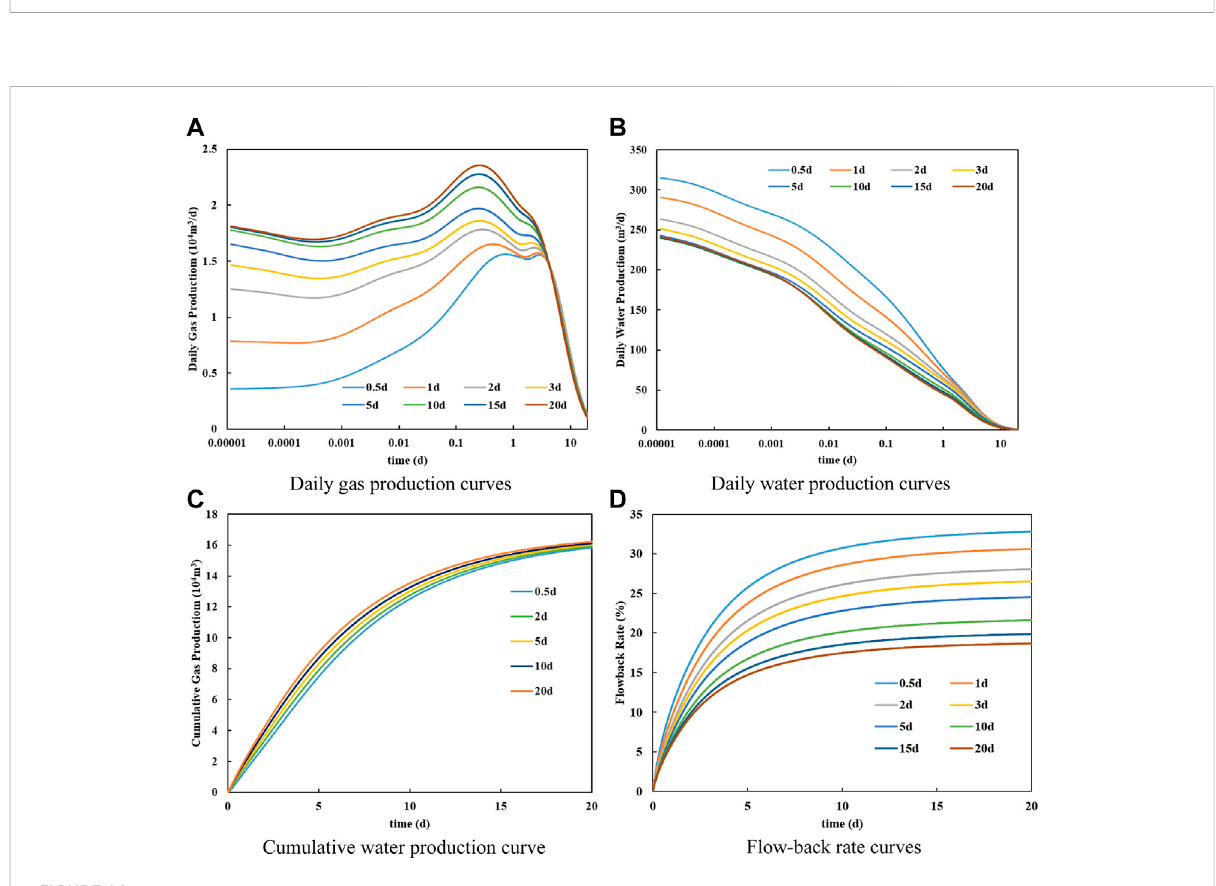
FIGURE 14 Production curves of shale gas well under different shut-in times. (A) Daily gas production curves. (B) Daily water production curves. (C) Cumulative water production curve. (D) Flow-back rate